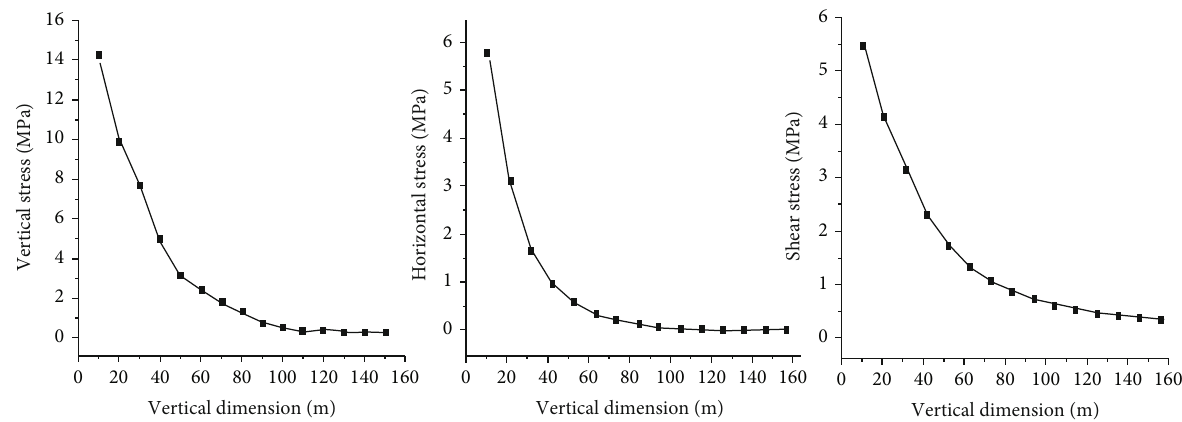
Figure 4: Variations in the fl oor stress components of the W coal seam as a function of the vertical